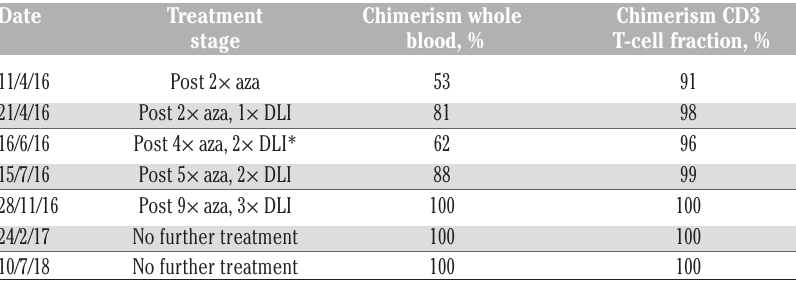
Table 1. Timeline of blood chimerism results and relation to